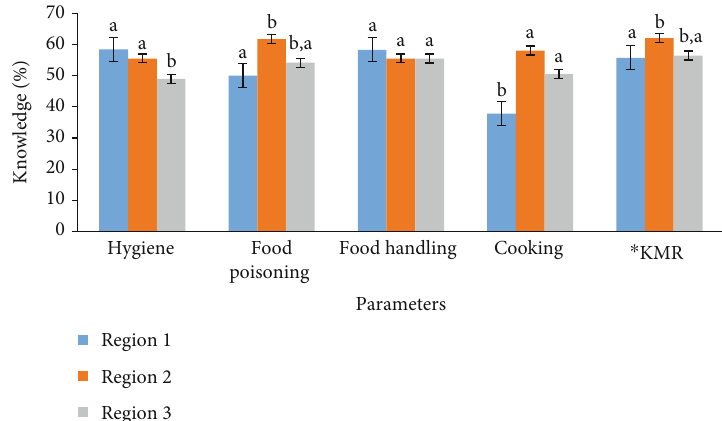
Figure 1: Food safety and hygiene knowledge of food handlers in restaurants among di ff erent regions in Muscat (di ff erent letters show signi fi cant di ff erence, p < 0 : 05 ). ∗ KMR: knowledge of the municipality rules.